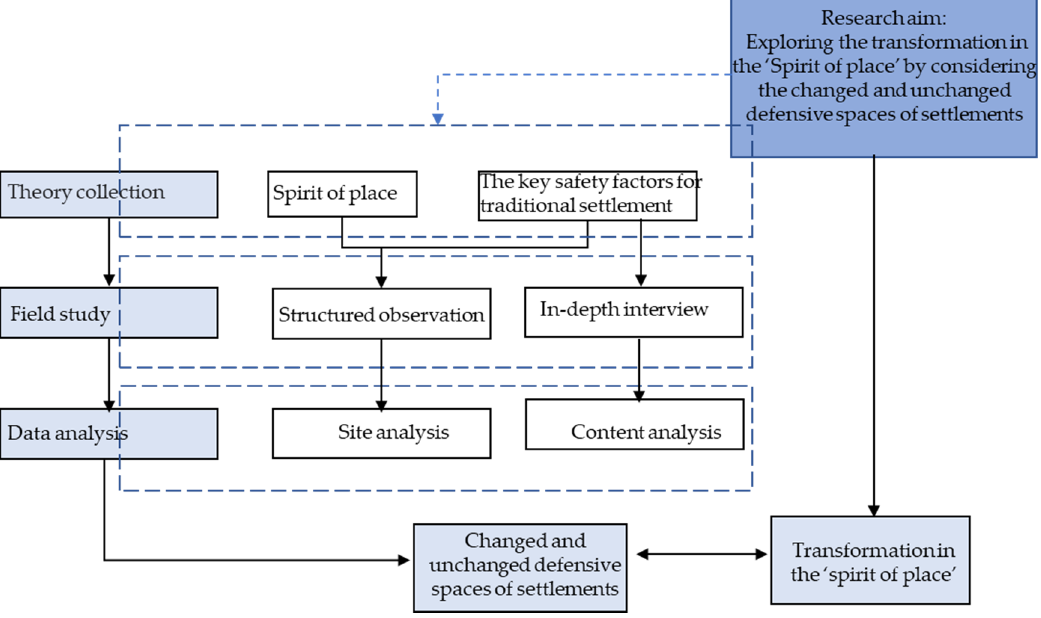
Figure 1. The research framework.